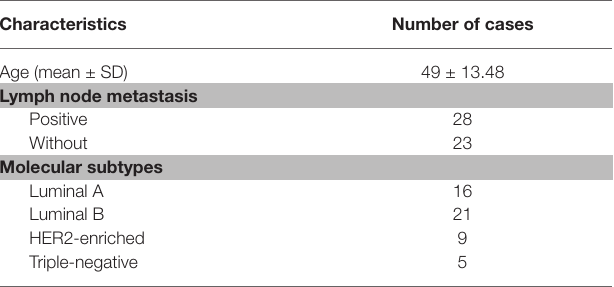
TABLE 1 | Baseline characteristics of patients with BC. Characteristics Number of cases